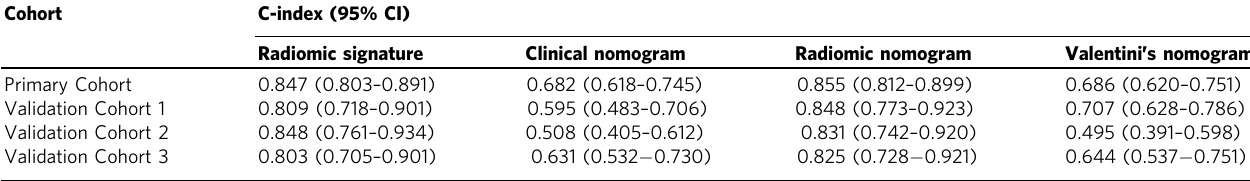
Table 2 The performances of the different models in the primary and validation